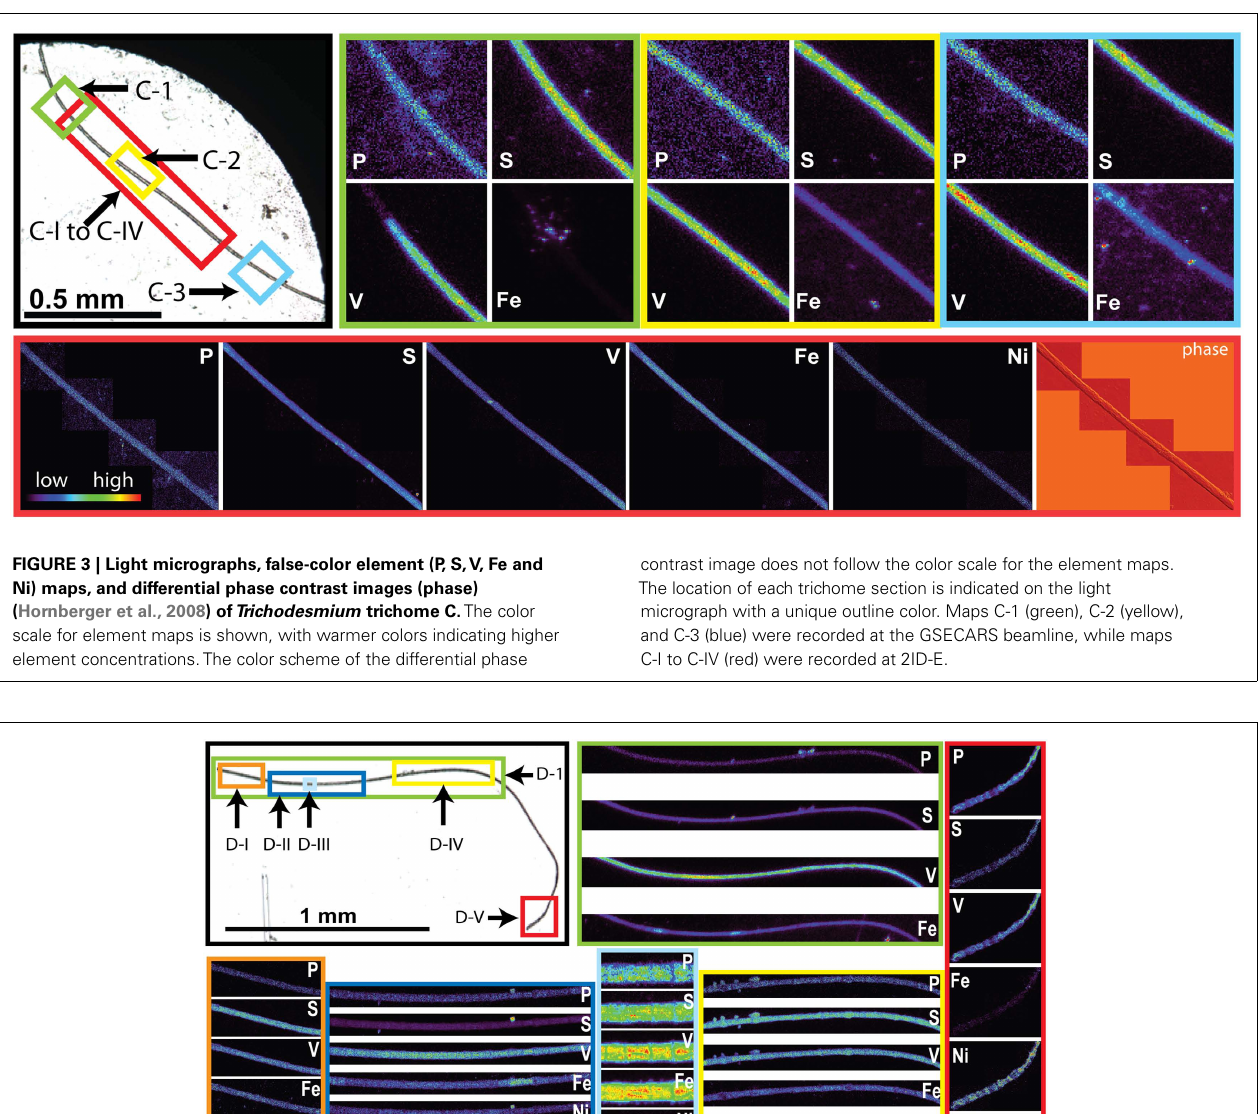
FIGURE 4 | Light micrographs, false-color element (P, S,V, Fe and Ni) maps, and differential phase contrast images (phase) (Hornberger et al., 2008) of Trichodesmium trichome D. The color scale for element maps is shown, with warmer colors indicating higher element concentrations.The color scheme of the differential phase contrast image